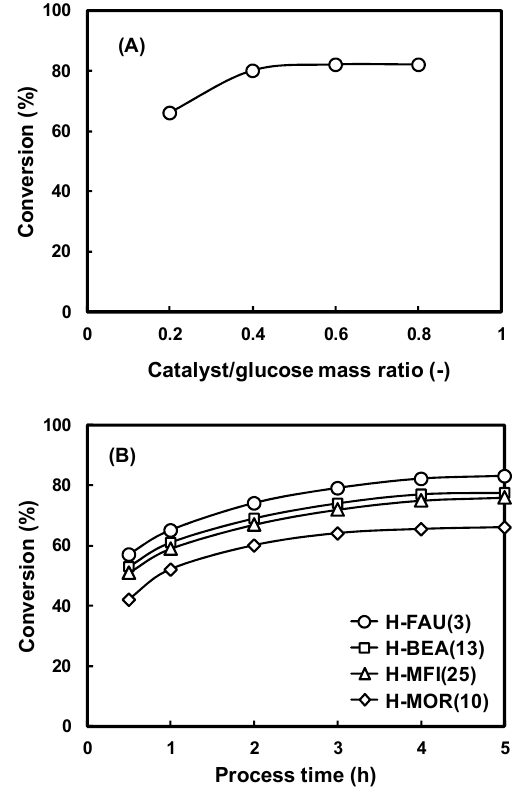
Figure 5. Variation of conversion of D ‐ glucose with loading amount of H ‐ MFI(50) zeolite catalyst: ( A ) at a process time of 4 h; and ( B ) variation of conversion of D ‐ glucose with process time on various zeolite catalysts in a catalyst/glucose mass ratio of 0.6 at 130 °C.